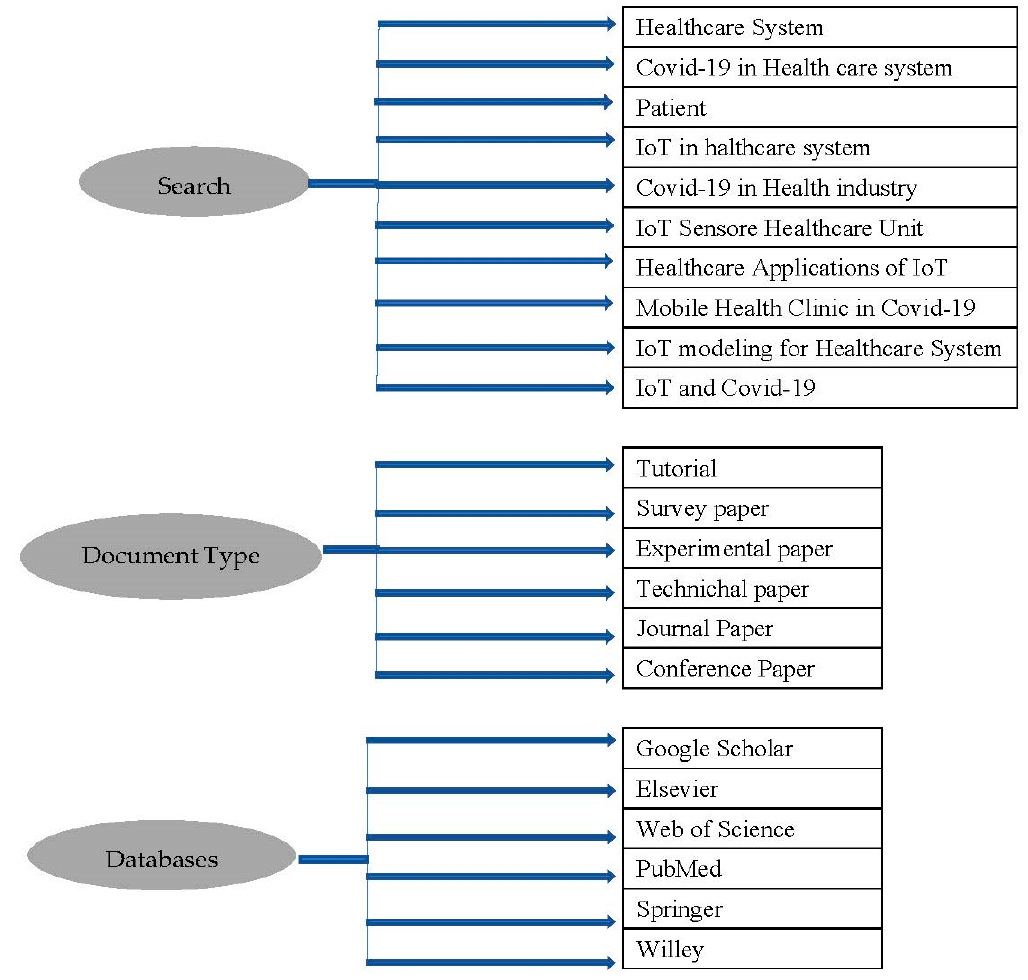
Figure 3. Data collection